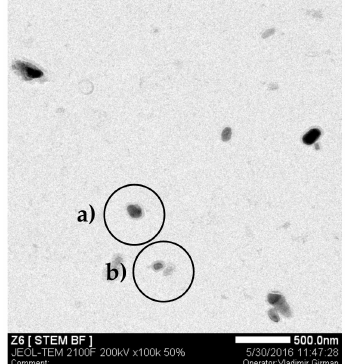
Figure 14. TEM, particles in sample Z6, CT900-2 ◦ . Particle on the base: ( a ) Ti, S, Nb; ( b ) N, Ti, C.